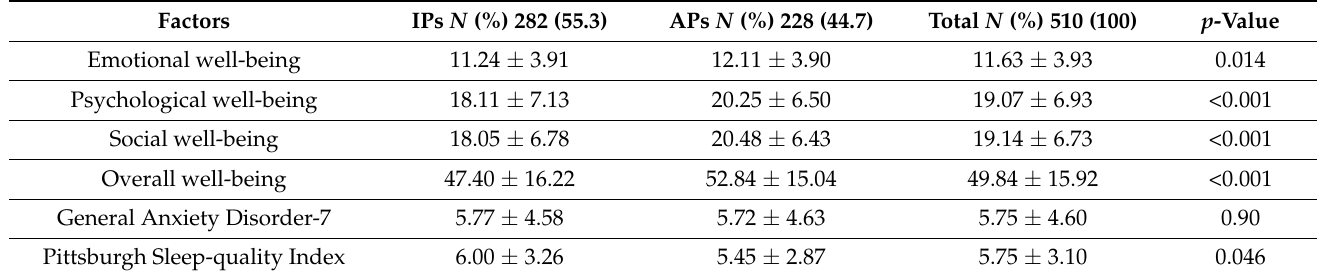
Table 3. Anxiety, well-being, and sleep-quality outcomes between IPs and